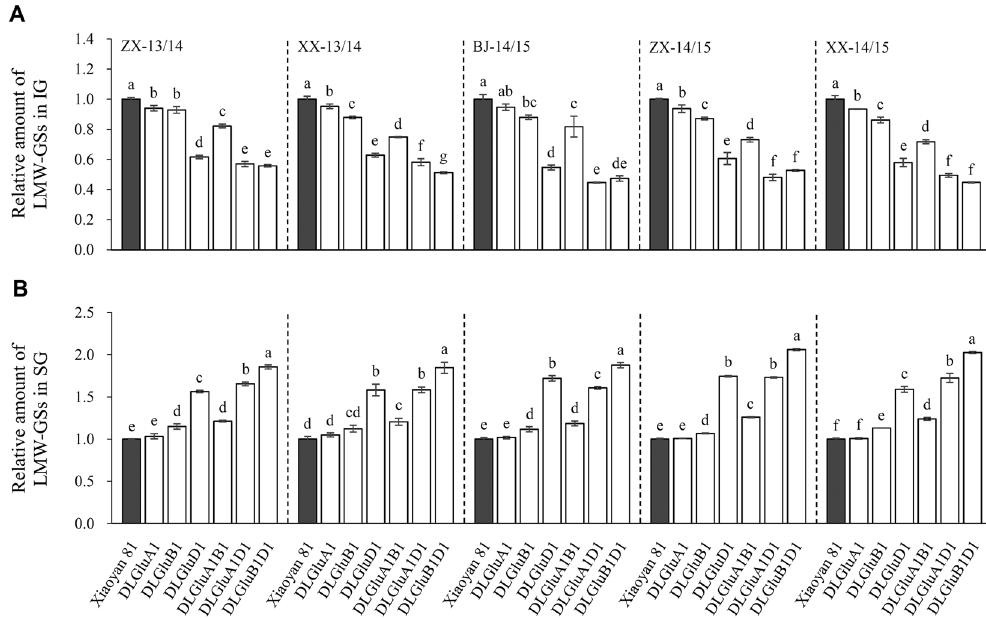
Figure 4. Changes in the amount of LMW-GSs in IG and SG in the six deletion mutants cultivated in five environments. Xiaoyan 81 and the six deletion lines (DLGluA1, DLGluB1, DLGluD1, DLGluA1B1, DLGluA1D1 and DLGluB1D1) were grown in two locations (ZX and XX) in 2013/2014 and three locations (BJ, ZX and XX) in 2014/2015. The resultant grain samples were analyzed for the amounts of LMW-GSs in the IG and SG fractions, respectively. The values shown are means ± SE of three separate tests, with that of Xiaoyan 81 being set as 1 to facilitate comparisons. In each environment, the means marked by different letters are statistically significant ( P < 0.05). The amounts of LMW-GSs in IG were generally decreased in the six deletion lines compared to that in Xiaoyan 81 ( A ). On the contrary, the amounts of LMW-GSs in SG were generally increased in the six deletion lines relative to that in Xiaoyan 81 ( B ). BJ, Beijing; IG, insoluble glutenin; LMW- GSs, low-molecular-weight glutenin subunits; SG, soluble glutenin; XX, Xinxiang; ZX,